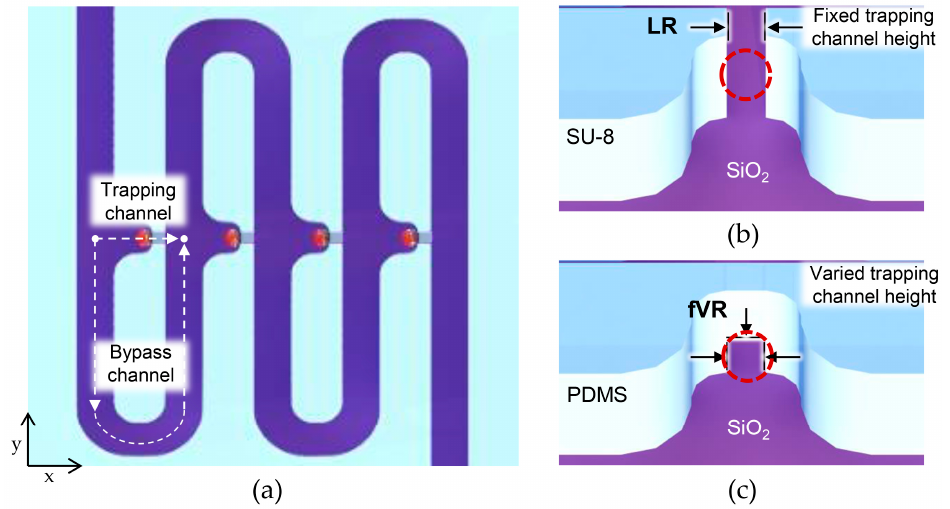
Figure 1. Schematic images of the deterministic cell capture: ( a ) schematic top view of the microfluidic device; ( b ) schematic illustrations of capture sites of the laterally restricted (LR)-type and ( c ) further vertically restricted (fVR)-type.